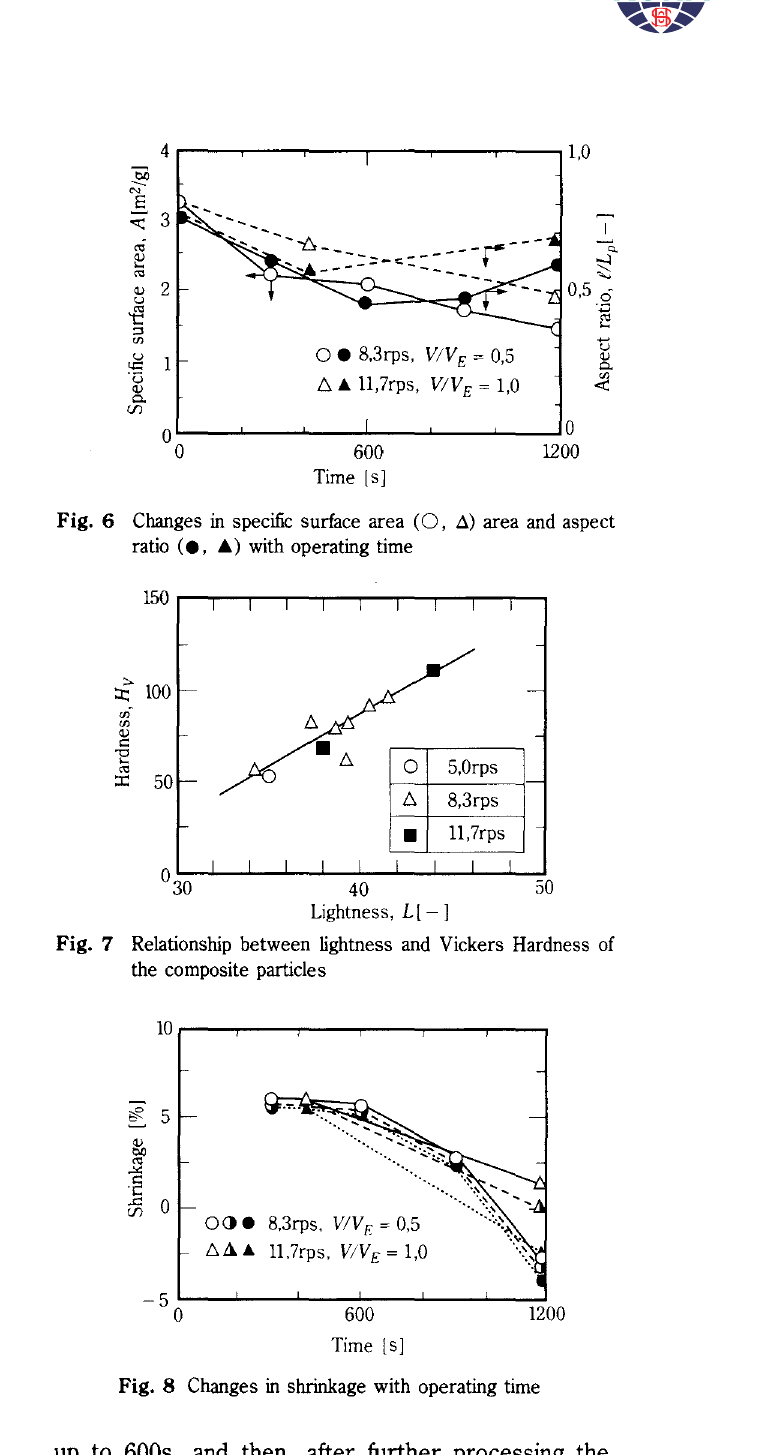
Fig. 8 Changes in shrinkage with operating